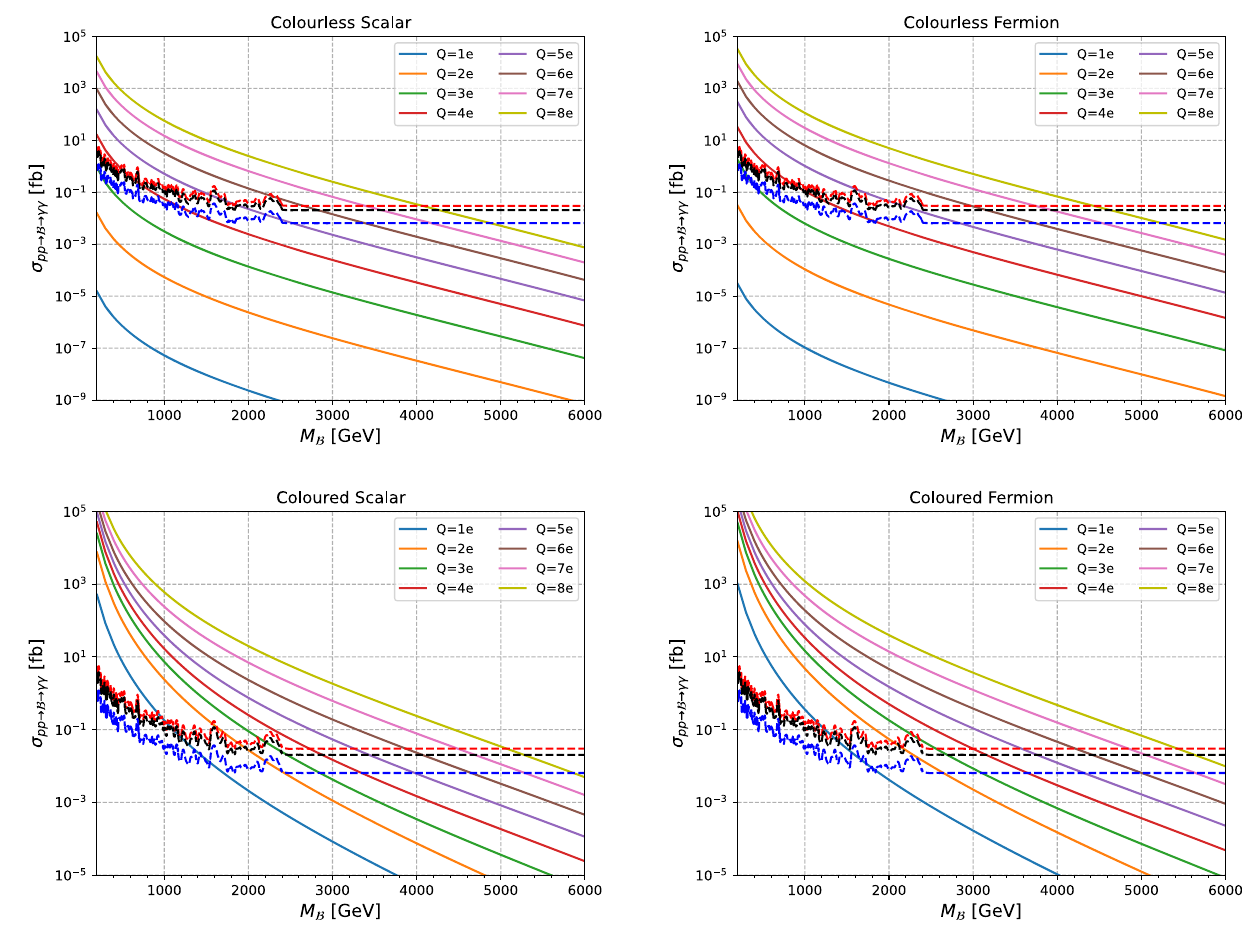
Fig. 10 Diphoton resonant production cross section for colour/colourless fermion and scalar multi charge particles which make bound sate of mass M B = 2 m . The Dashed lines: expected 95% CL upper bounds from ATLAS corresponding to an integrated luminosity, L = 139 (red), 300 (black) and 3000 fb − 1